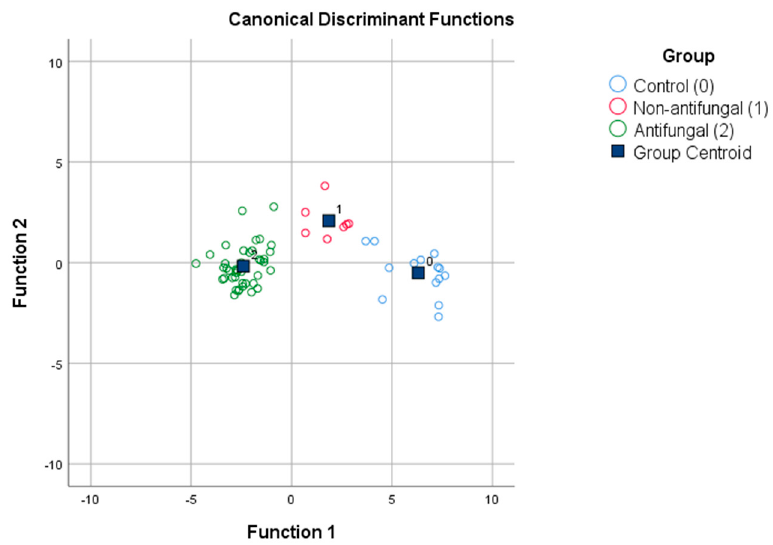
Figure 2. LDA. Linear discriminant analysis (LDA) classifies EEP samples by their low or high antifungal activity and control ethanol solvent. The original data were obtained using the NeOse Pro opto-electronic nose with 63 different sequences of peptides on a sensor array. Table 3. Classification results. Original and cross-validated classification of propolis samples with very low antifungal (non-antifungal) or high antifungal (antifungal) capacity are displayed with the vehicle control (control). The samples were classified by linear discriminant analysis (LDA).